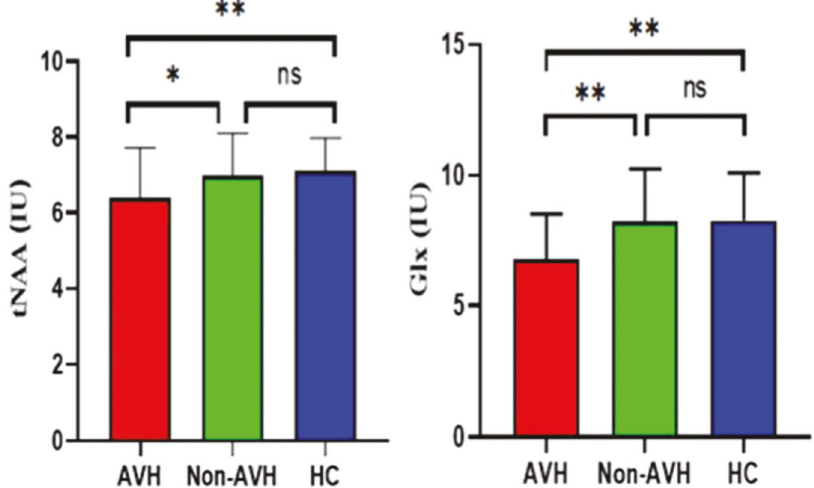
Fig. 2 Differences in brain metabolites in the medial prefrontal cortex (mPFC) among the three groups of participants. The patients with persistent auditory verbal hallucinations (pAVH) displayed signi fi cant reductions in levels of Glx and tNAA, compared to patients without AVH (non-AVH) (tNAA: p = 0.022, Glx: p = 0.012) and healthy controls (HC) (tNAA: p = 0.001, Glx: p = 0.001). No signi fi cant inter-group differences were found between non-AVH and HC. Error bars represent standard deviations. IU institutional units. ns not signi fi cant. * p < 0.05, ** p <